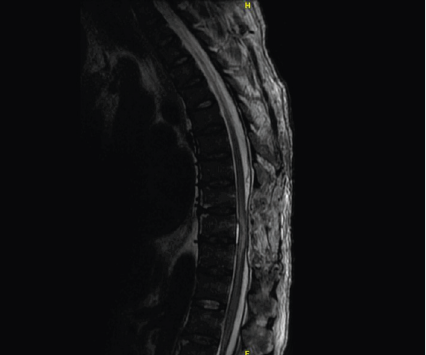
Figure 3: Postoperative MRI sagittal view showing T8–T10 lam- inectomy with mild dilatation of the cord and a T2 signal ab- normality within the cord from the T7-8 through the T10-11